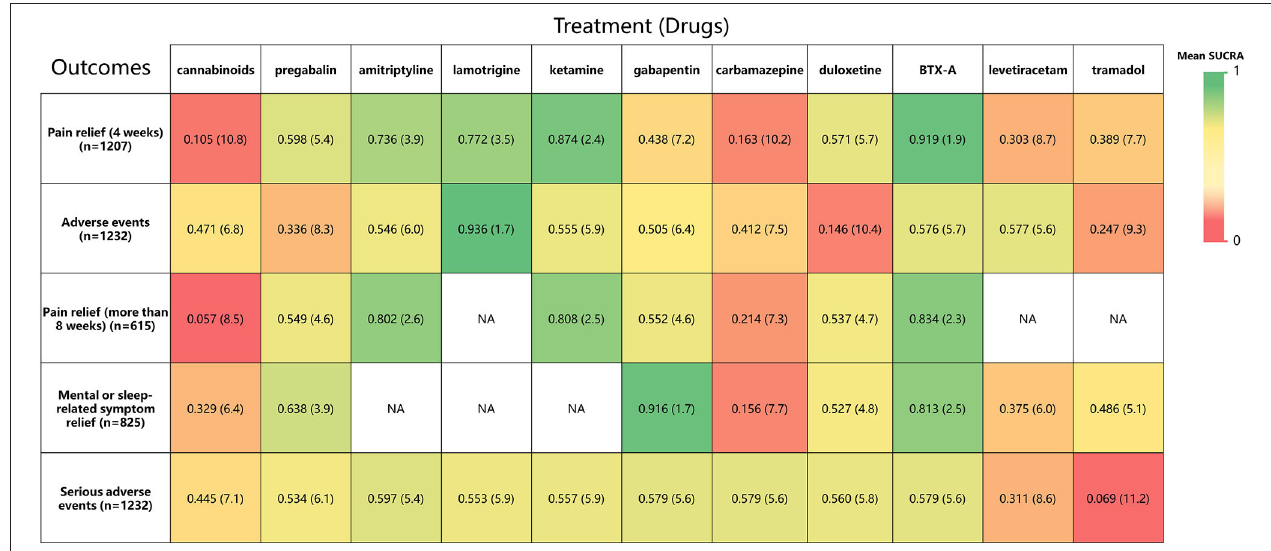
FIGURE 7 | A heat map of 11 treatment drugs studied in patients with SCI with neuropathic pain for 5 outcomes. Each column represents a treatment drug, and each row represents an outcome. For each outcome (Column 1), the number of studies included in the analysis is presented in parentheses. SUCRA, surface under the cumulative ranking curve. Each box is colored according to the mean SUCRA value of the corresponding treatment and outcome. The color scale consists of values that represent mean SUCRA, which ranges from 0 (red, indicating a treatment is always last) to 1 (green, indicating a treatment is always first). Uncolored boxes labeled NA (data not available) show that the underlying treatment was not included for that particular outcome. The values in each box represent the mean SUCRA value and mean rank of the corresponding drug and